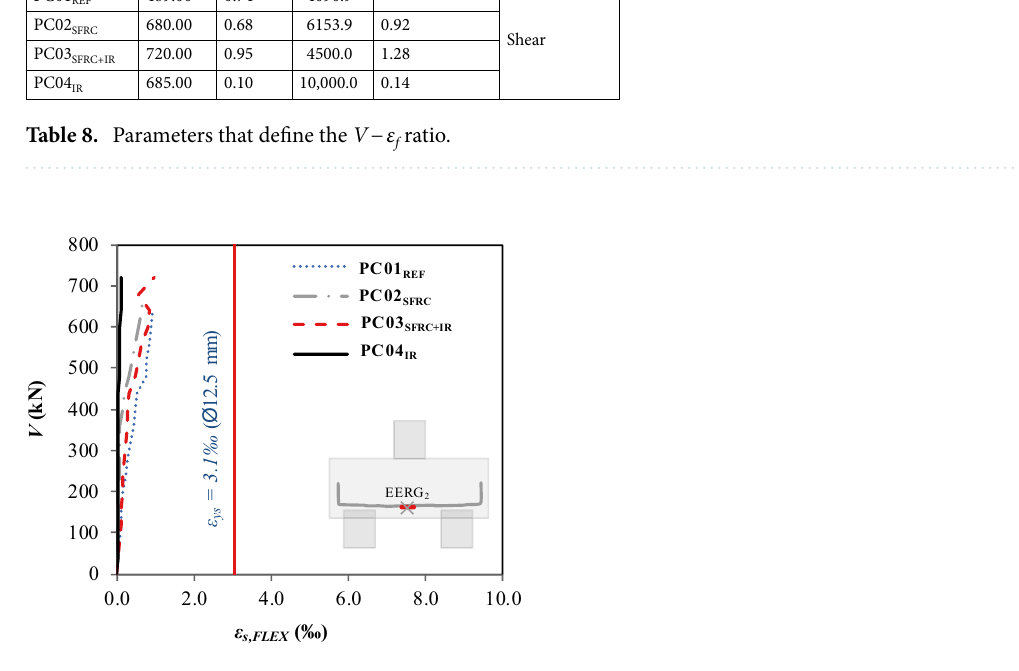
Figure 10. Load–strain ratio of the flexural